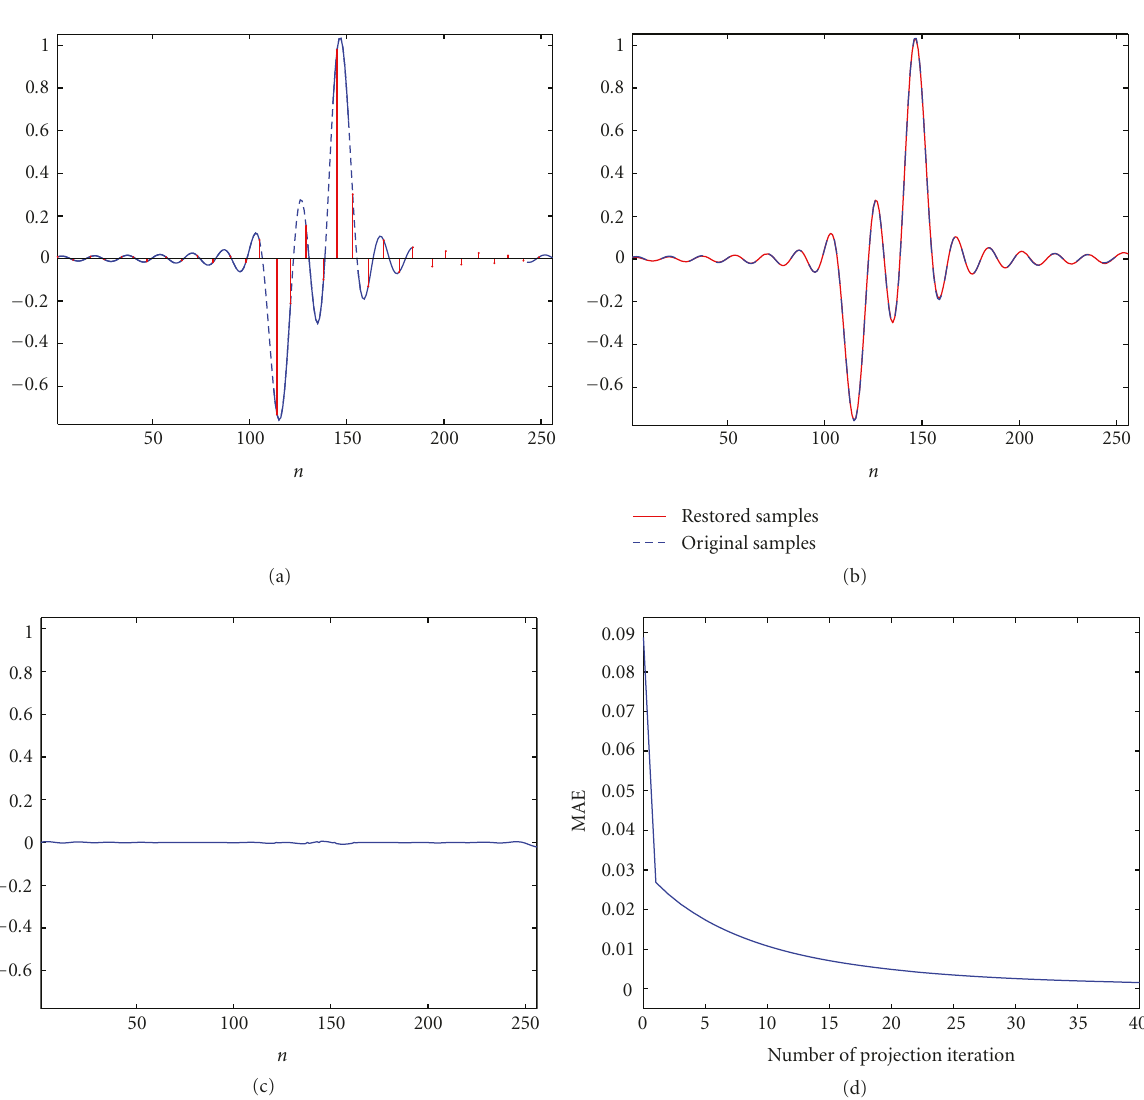
Figure 4: Restored results for the test signal x 1 ( n ) (a) Irregularly spaced subsamples ( L = 8, τ ∼ N (0,1)), (b) restored signal, (c) error, and (d) convergence